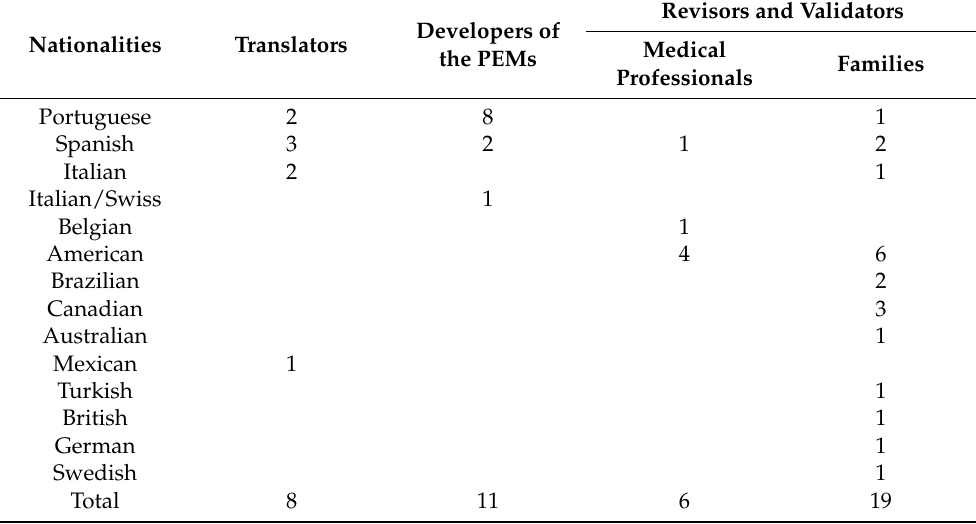
Table 2. Professionals and families committee, divided by nationality and specific task. Translators: healthcare professionals, researchers and students from life sciences; developers of the PEMs: re- searchers and natural science students; revisors and validators: healthcare professionals and families. Revisors and Validators Developers of Nationalities Translators Medical the PEMs Families Professionals Portuguese 2 8